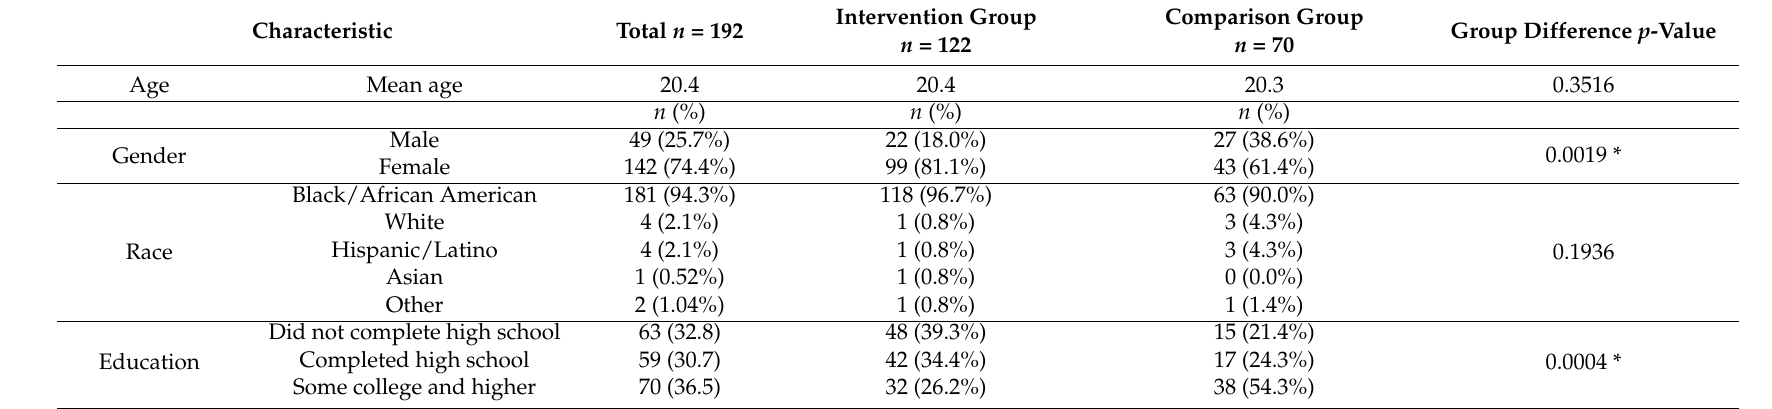
Table 1. Baseline characteristics between study groups.